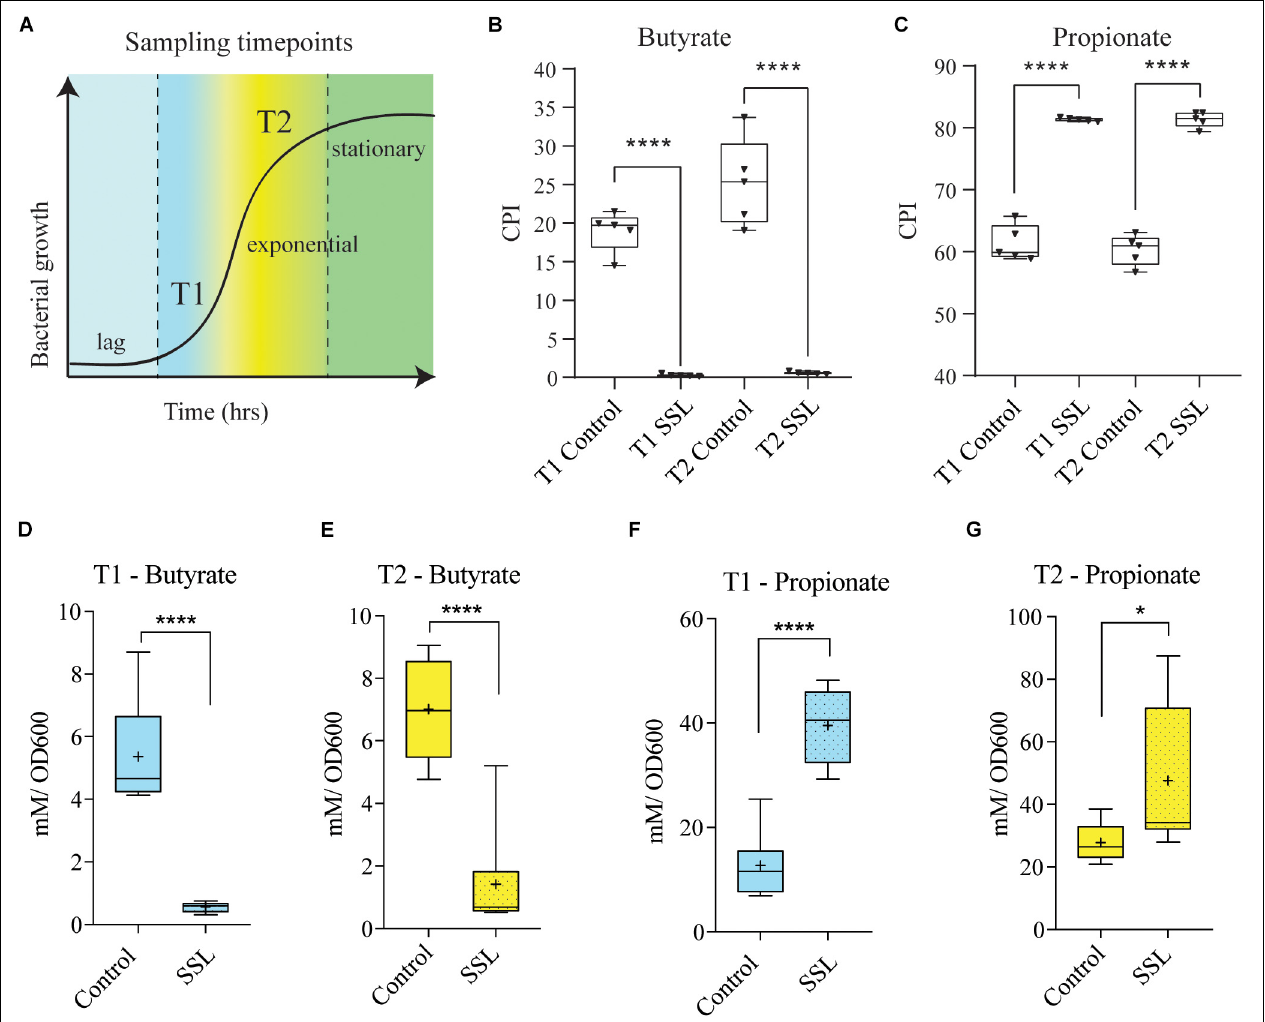
FIGURE 5 | SSL reduces the capacity of the bacterial culture to produce butyrate. (A) Schematic of experimental design. Sampling timepoint T1 and T2 represents early log phase and the end of exponential phase, respectively, in cultures of fecal bacteria in CDM. (B) Community phenotype index (CPI) shows the percentage of bacterial community members that encoded complete butyrate pathways, predict that control cultures at both timepoints produce significantly more butyrate (20%, 25% butyrate producers) than the SSL-treated cultures ( < 1% of butyrate producers). (C) CPI showing the percentage of bacterial community members that encode complete propionate pathways, predict that SSL-treated cultures ( > 80%) at both timepoints produce significantly more propionate than controls ( ∼ 60%). (D,E) Butyrate production as measured by GC-MS was significantly higher in control cultures compared to SSL-treated cultures at both T1 and T2. (F,G) Propionate production as measured by GC-MS was significantly lower concentration in control cultures relative to SSL-treated cultures at both T1 and T2. Bacterial culture experiments and SCFA analysis: n = 9–10, two biological replicates. Statistical significance of pairwise comparisons was determined with a two-tailed Student’s t -test, using Graph Pad Prism * < 0.05, ** < 0.01, *** < 0.001, **** <